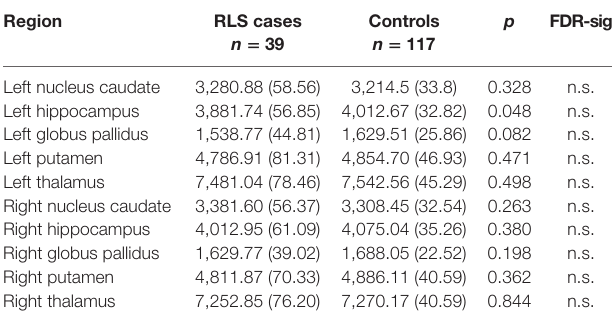
TaBle 2 | Comparison of subcortical volumes (mm 3 and SE) across groups. a